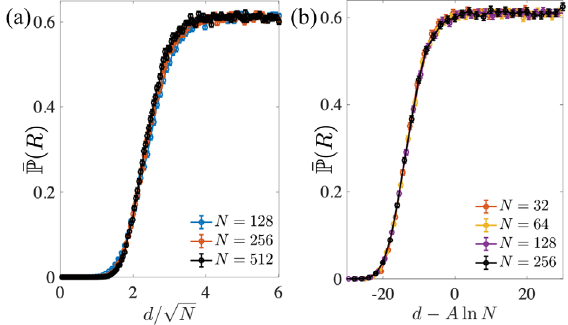
ffiffiffiffi p N